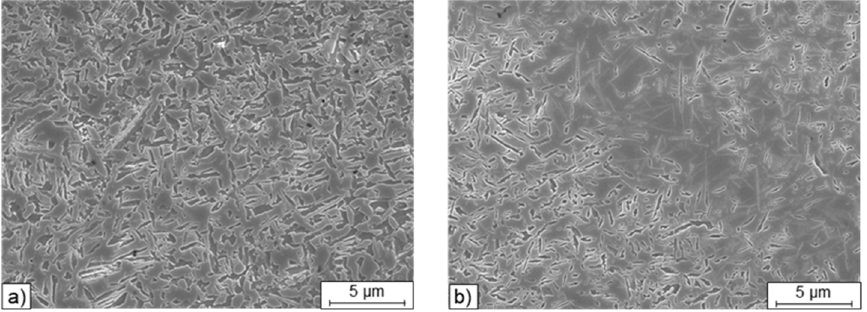
Figure 12. SEM of the microstructure of M3* from Figure 11 around a mean ( a ) and a harder region ( b )